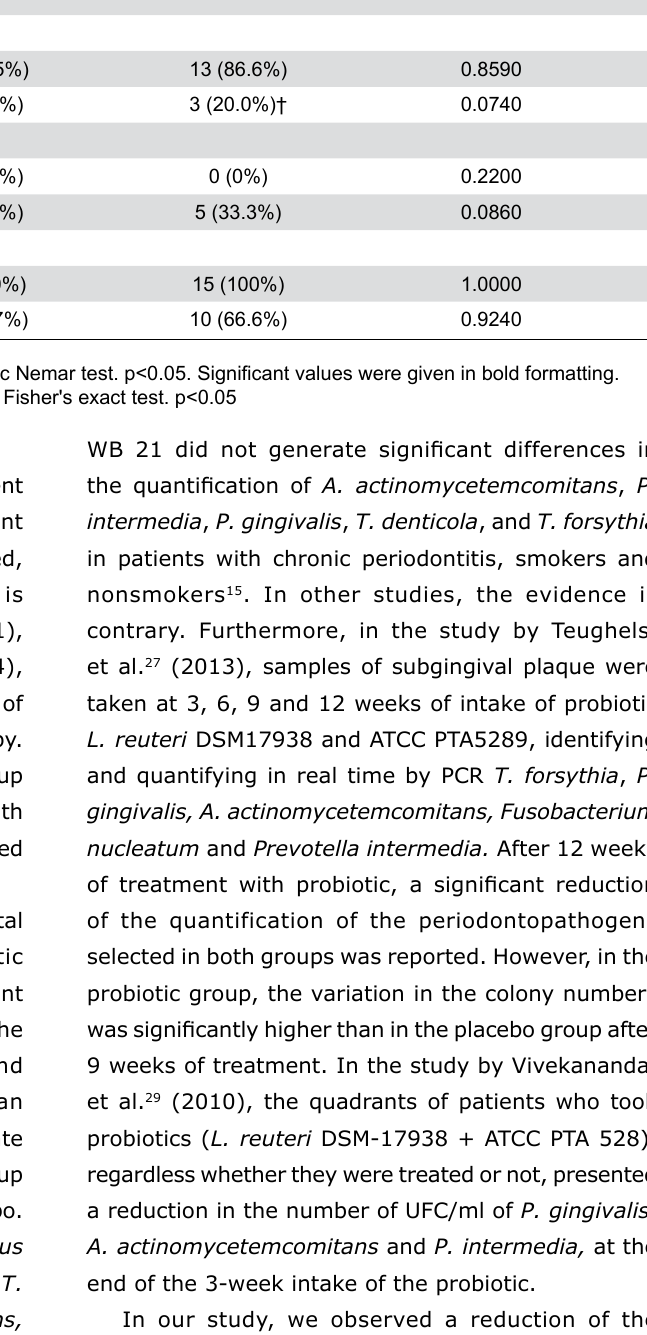
Table 3- Intra- and intergroup comparisons of microbiological parameters (mean ± SD or median, IQ score at days 0 and 270 Variable Time point